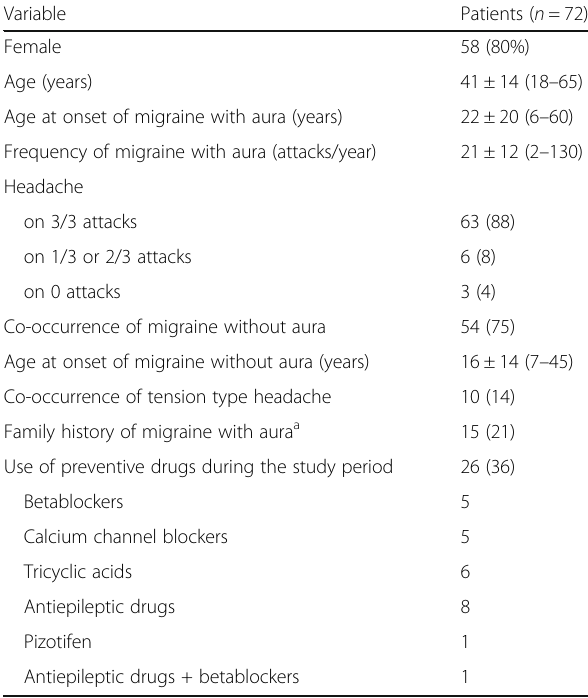
Table 1 Characteristics of patients ( n = 72). Data is presented as means ± SD (range) for continuous data and as n (% of column) for categorical variables